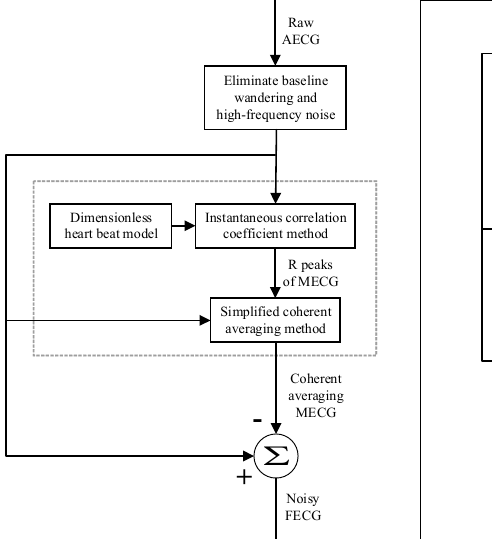
Figure 2. The extraction and enhancement of foetal electrocardiograms (FECGs) obtained using the proposed method for the DaISy database.